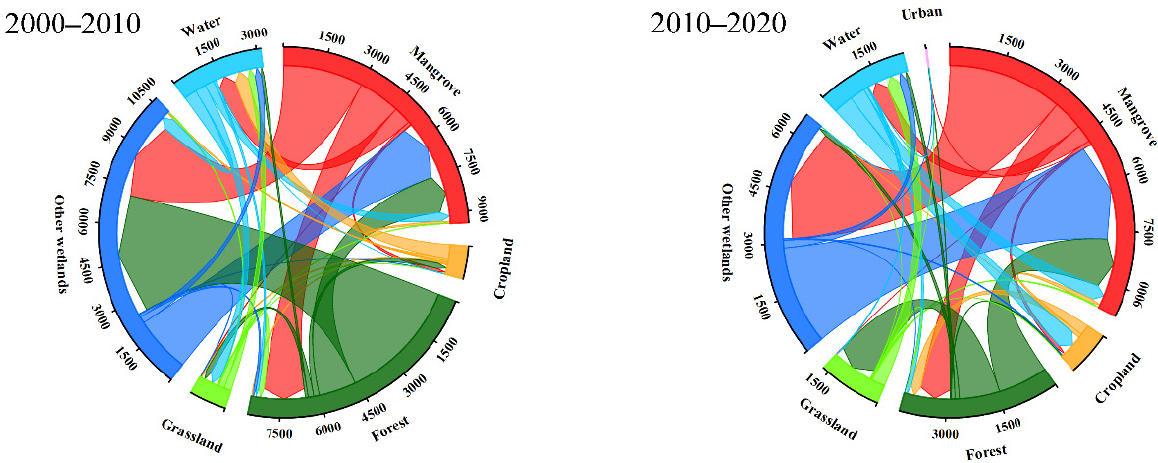
Figure 8. Transfer direction between the different land-use types in Sembilang NP (( left ): 2000–2010, ( right ): 2010–2020).